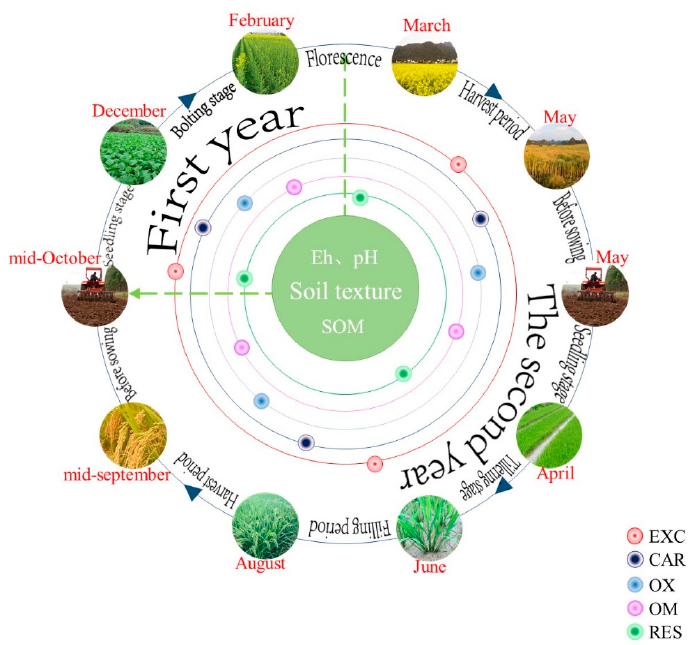
Figure 1. Design of field experiments. (Note: EXC is the exchangeable fraction, CAR is carbonate fraction, OX is iron-manganese oxide bound fraction, OM is organic-bound fraction, RES is residual fraction).